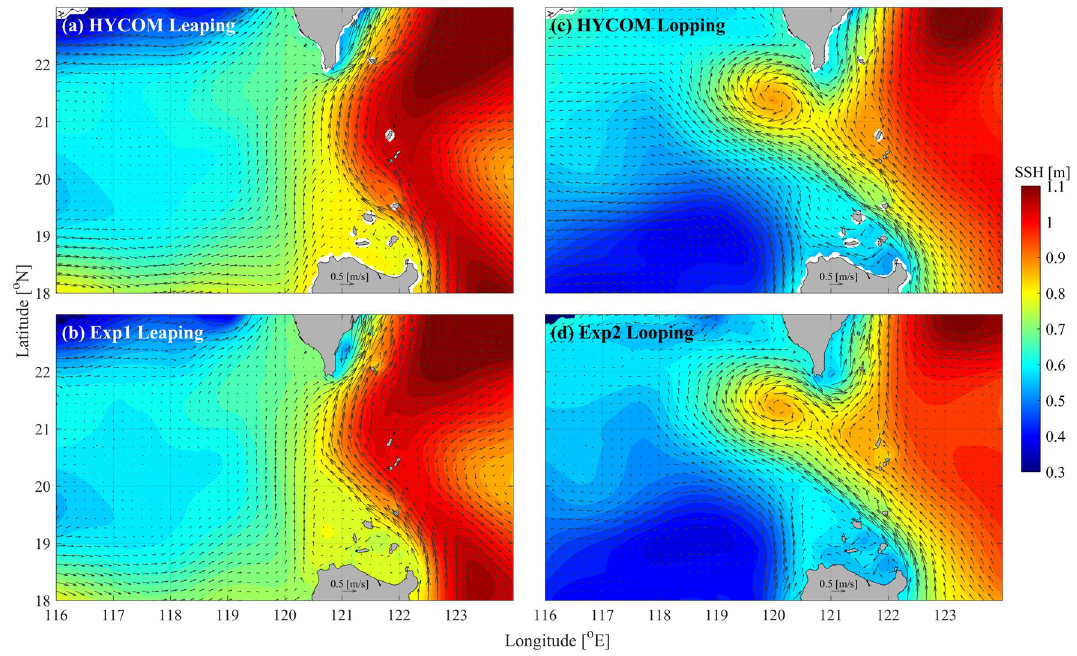
Figure 3. Comparisons of averaged sea surface height (shadings, units: m/s) and velocity (black arrows, unit: m/s) between ( a,c ) HYCOM data and ( b,d ) model results.